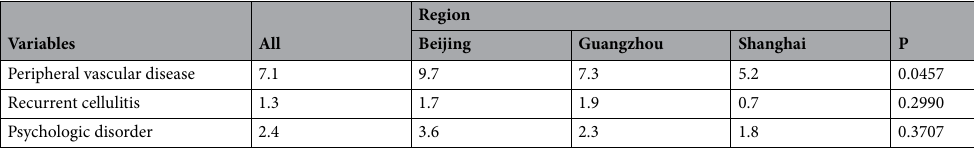
Table 1. Demographics and patient characteristics of the cohort study by region. BMI body mass index, CGN chronic glomerulonephritis, DN diabetic nephropathy, HT hypertensive nephropathy, spKt/V single-pooled Kt/V, stdKt/V standardized Kt/V, HDF hemodiafiltration, Hgb hemoglobin, ALB albumin, TSAT transferrin saturation, cCa corrected calcium, P phosphate, iPTH intact parathyroid hormone, PCS physical component summary, MCS mental component summary.